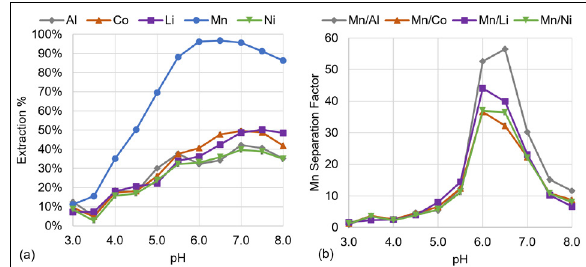
Figure 4: Effect of pH on the (a) extraction efficiency and (b) Mn separation factor of Cyanex 272.